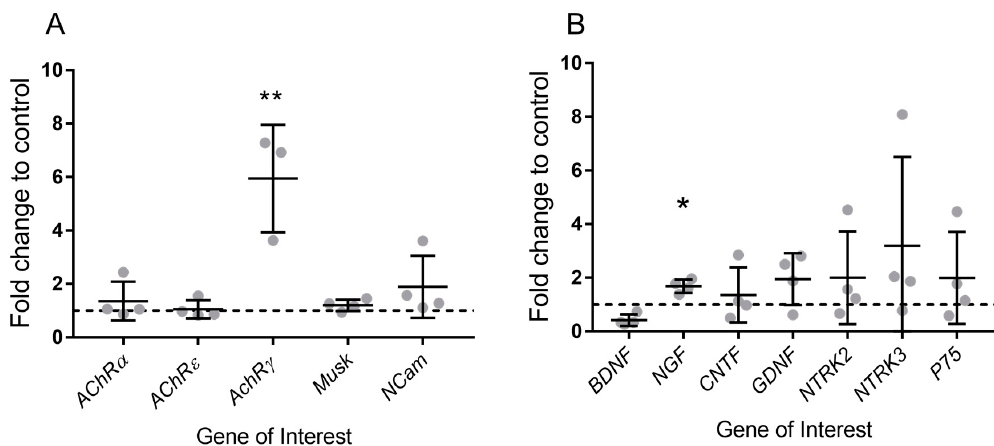
Figure 6. Denervation and reinnervation markers in Sh3tc2 ∆ Ex1 / ∆ Ex1 ( n = 4) and control ( n = 4) mice. QPCR analysis of; ( A ) Denervation markers: AChR α , AChR ε , AChR γ , MuSK and NCam and of reinnervation markers: BDNF, NGF, CNTF, GDNF, NTRK2, NTRK3, p75 in gastrocnemius muscle of 6 months old control and Sh3tc2 ∆ Ex1 / ∆ Ex1 mice (unpaired t -test) ( B ). Values for Sh3tc2 ∆ Ex1 / ∆ Ex1 animals were normalized to control animals, dashed line = 1 (control animals). Graphs are mean ± SEM, * p < 0.05, ** p < 0.005.